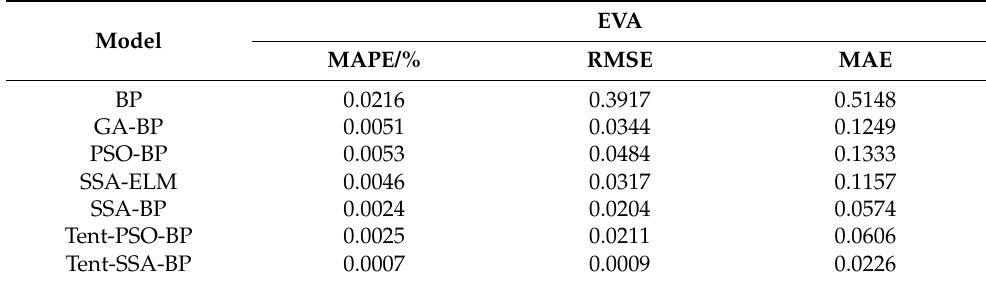
Table 4. Prediction error